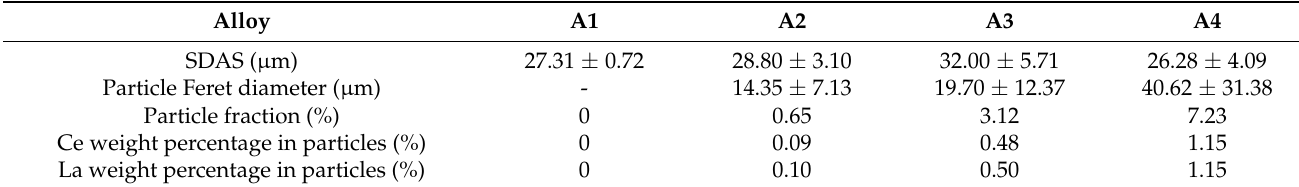
Table 3. Microstructural scales and fractions of intermetallics.